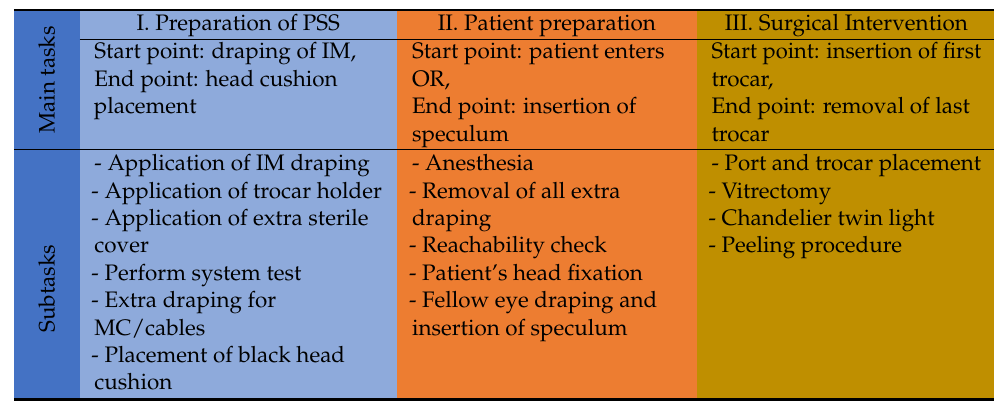
Table 1. Definitions of the three main tasks of preoperative and operative steps and the associated subtasks. PSS = Preceyes Surgical System, IM = instrument manipulator, MC = motion controller, OR = operating